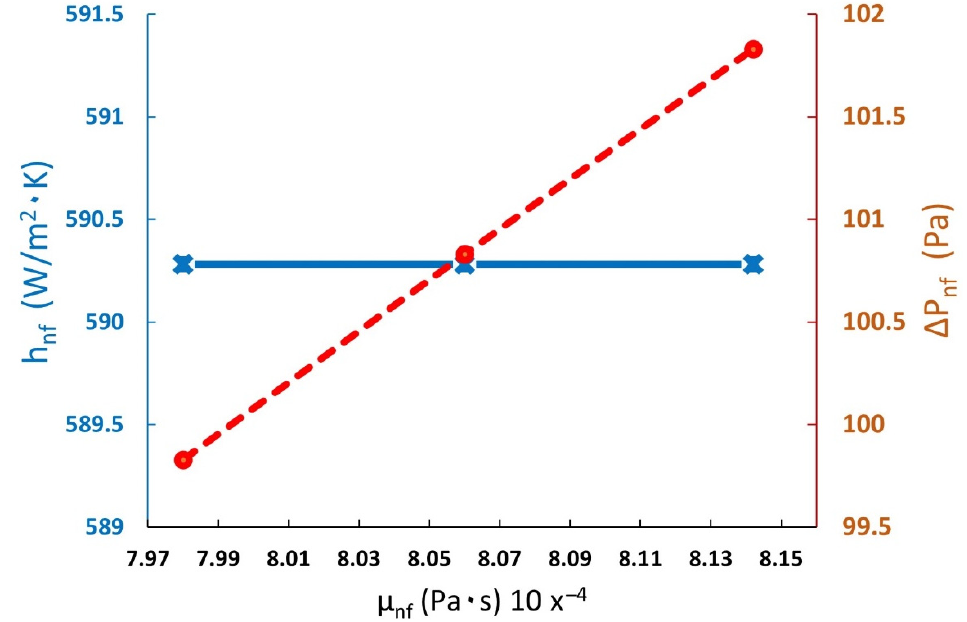
Figure 11. Heat transfer coefficient and pressure drop versus the nanofluid variation viscosity enhancement (blue solid line represents heat transfer coefficient and red dash-dotted line represents pressure drop).